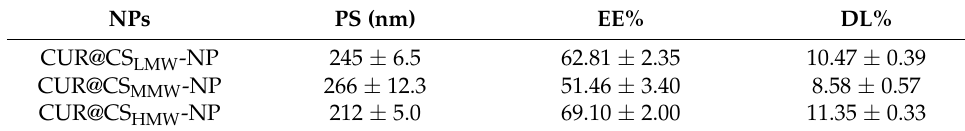
Table 4. Size, drug loading, and encapsulation rates of different NPs.